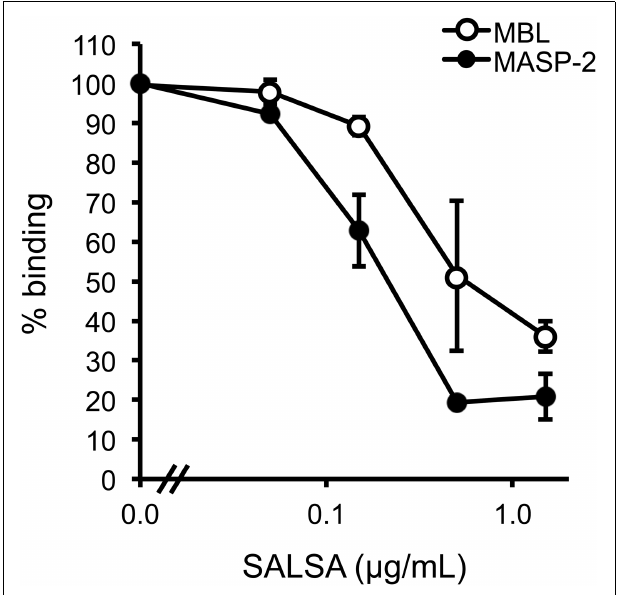
FIGURE 5 |The effect of SALSA on the binding of MBL to its microbial targets C. albicans and E. coli . In a flow cytometry assay C. albicans and E. coli were incubated with a mixture of rMBL (0.9 μ g/ml) and rSALSA (0–45 μ g/ml). Binding of MBL was detected with an anti-MBL antibody. The binding of MBL to C. albicans and E. coli decreased dose-dependently when SALSA was present.The results are expressed as percentage of MFI in the absence of SALSA. Averages and SDs of three separate experiments are shown.